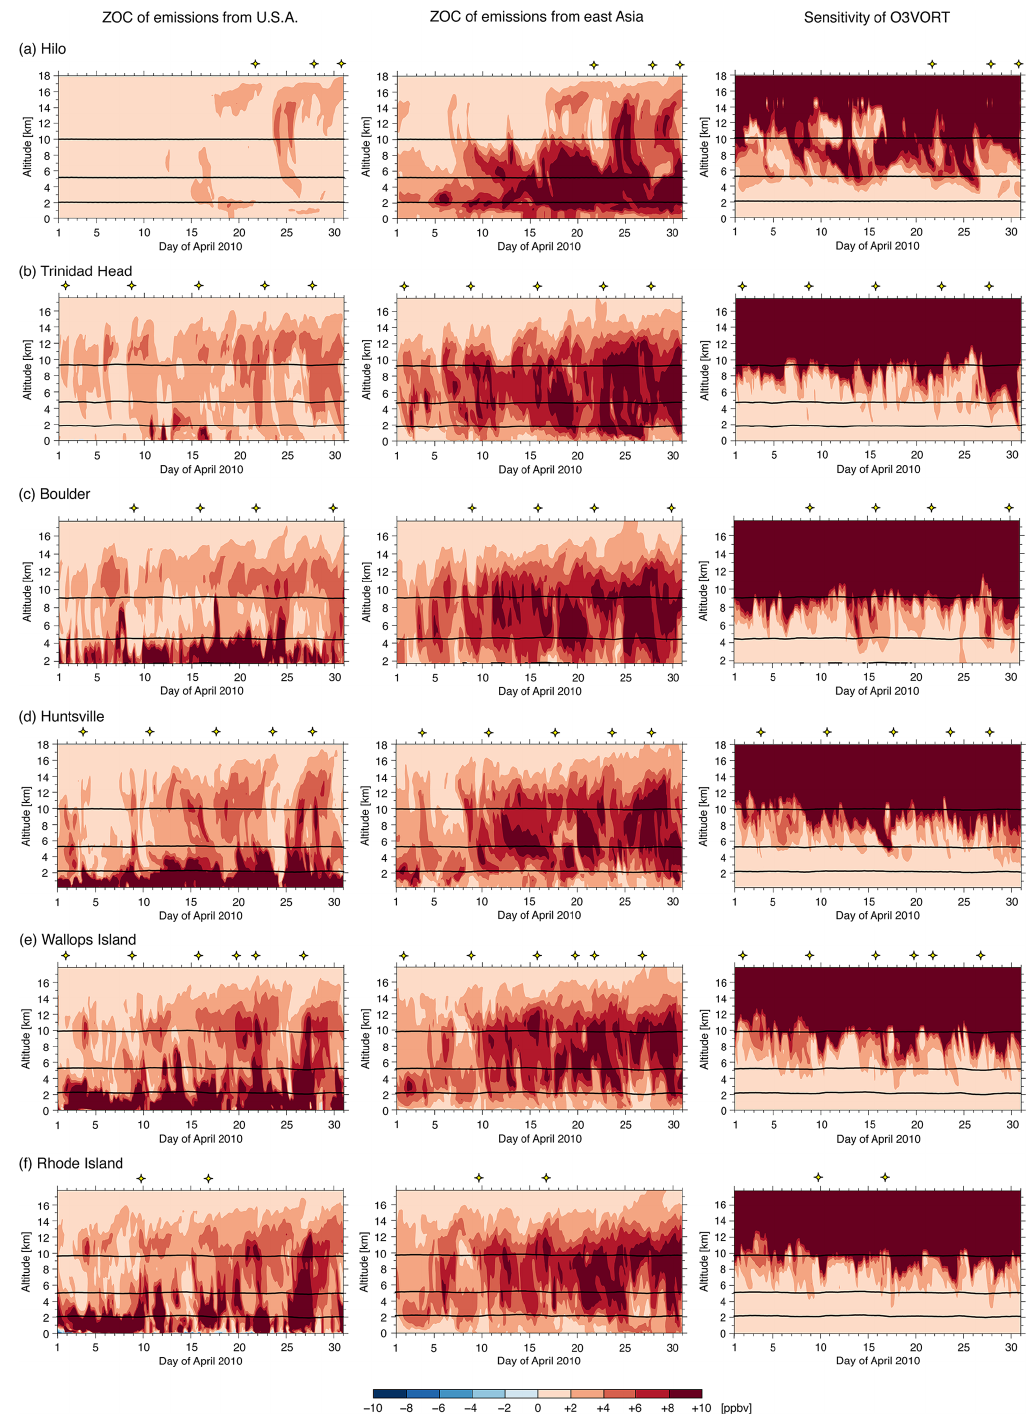
Figure 8. Curtain plots of (left) ZOC of emissions from the US, (center) ZOC of emissions from east Asia, and (right) sensitivity of O3VORT at US ozonesonde sites of (a) Hilo (HI), (b) Trinidad Head (CA), (c) Boulder (CO), (d) Huntsville (AL), (e) Wallops Island (VA), and (f) Rhode Island during April 2010. Yellow stars indicate the time of available ozonesonde measurements. Thick lines from bottom to top indicate 750, 500, and 250hPa as a representative bottom, middle, and top of free